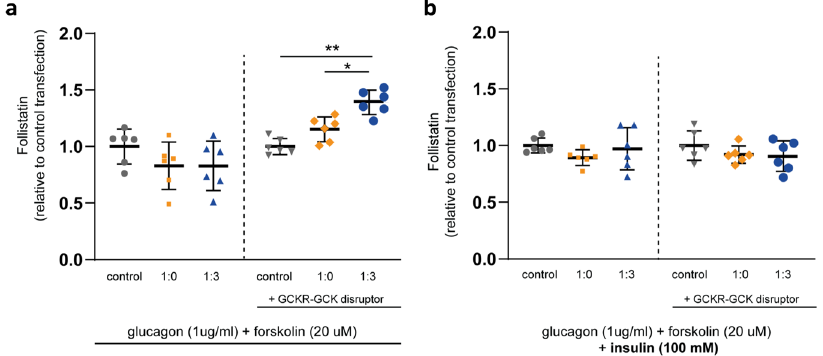
Fig. 4 Liver cell follistatin secretion is controlled by the glucokinase regulatory protein- glucokinase (GCKR-GCK) complex. a Human liver carcinoma- derived HepG2 cells were transfected with plasmids as indicated: (i) control (pCMV-XL4, grey round plots); (ii) GCK:GCKR (1:0; no GCKR, orange square plots); (iii) GCK:GCKR (1:3, blue triangle plots). Forty-eight hours after transfection, cells were serum starved in 5.5 mM DMEM for 3 h, and a GCKR-GCK disruptor molecule AMG-3969 (0.7 μ M) was added in the medium for 30 min. Cells were then incubated in serum-free low glucose (5.5 mM) DMEM containing glucagon (0.3 µ M) and forskolin (20 µ M), and AMG-3969 (0.7 μ M) was added to respective wells. After 4-hour incubation, the medium was collected for follistatin assay by ELISA. Follistatin levels were normalized to the protein concentration within each sample. b HepG2 cells were treated as described in panel a , but in the presence of insulin (100 mM). Two independent experiments with 3 technical replicates per condition were performed in different days using different plasmid preparations and cell passage numbers ( n = 6; * p = 0.03 and ** p = 0.005; ANCOVA with “ experiment ” as covariable and LSD post-hoc test; data are presented as mean values + / −